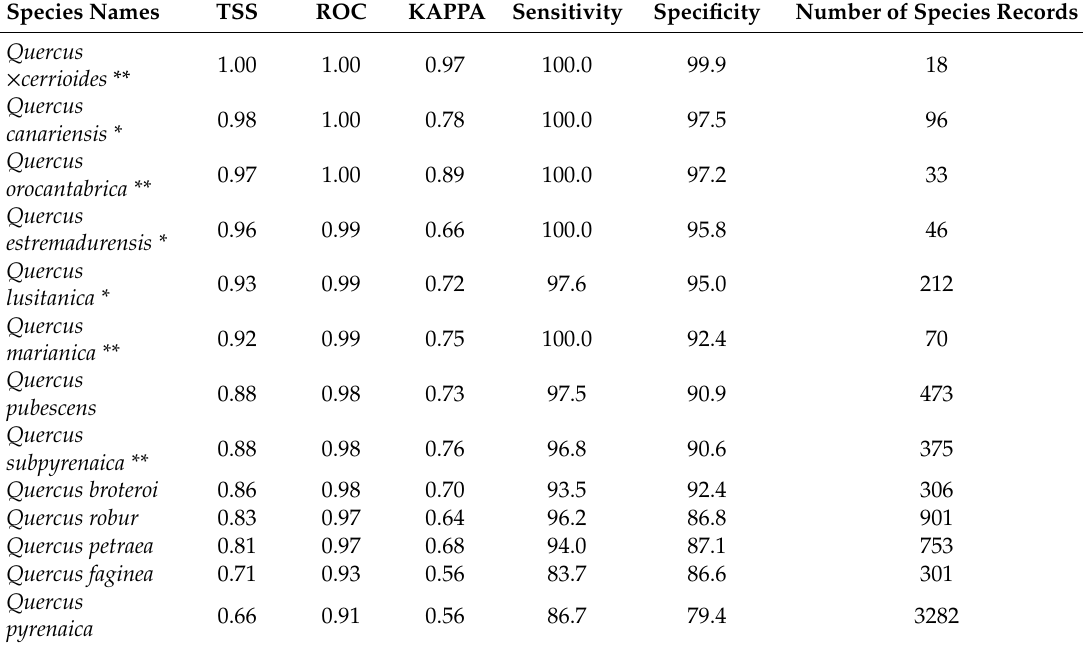
Table 1. Evaluation scores per studied species for the ensemble of 30 top-models combining both climate and satellite-based EFA variables (TSS: true skill statistic; ROC: area under the receiver operating curve; KAPPA: Cohen’s Kappa; sensitivity (also called true positive rate or recall); specificity (also defined as the true negative rate)). The number of species records presented are computed after removing duplicates and applying the spatial thinning algorithm for imposing a minimum separation distance of 3 km between points ( spThin ). * narrow distributed; **